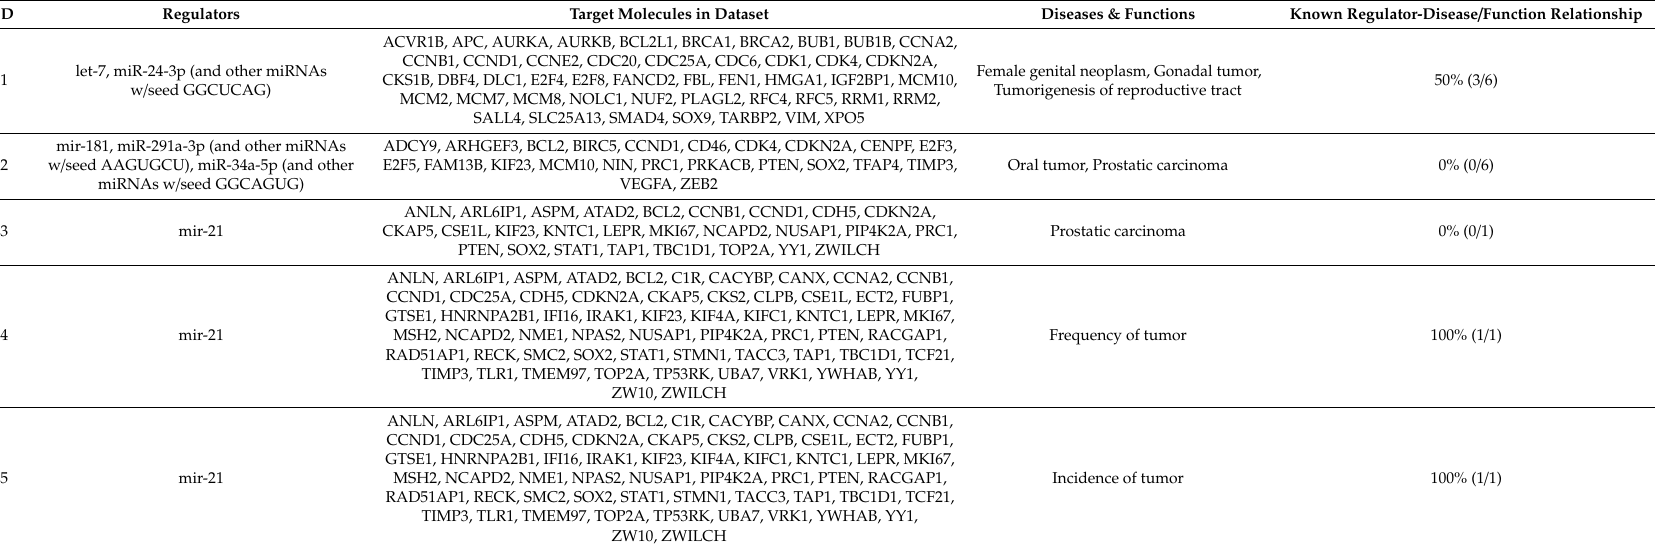
Table 6. MicroRNA (miRNA)-related regulator e ff ect networks in di ff use-type gastric cancer